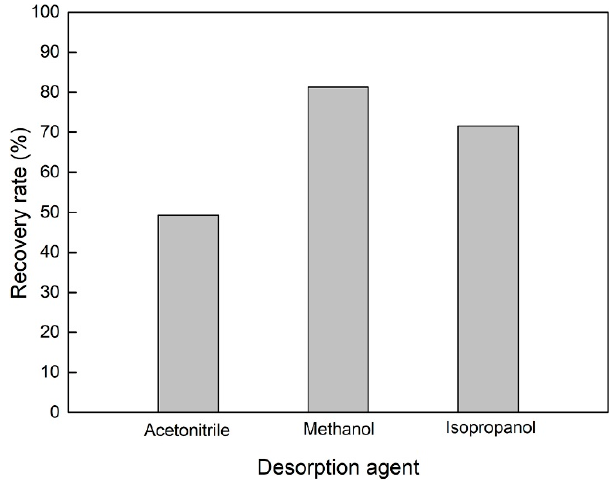
ff ect of desorption agent on the recovery of catechol. Figure 11. Effect of desorption agent on the recovery of catechol. Figure 11. E Figure 11. Effect of desorption agent on the recovery of catechol.